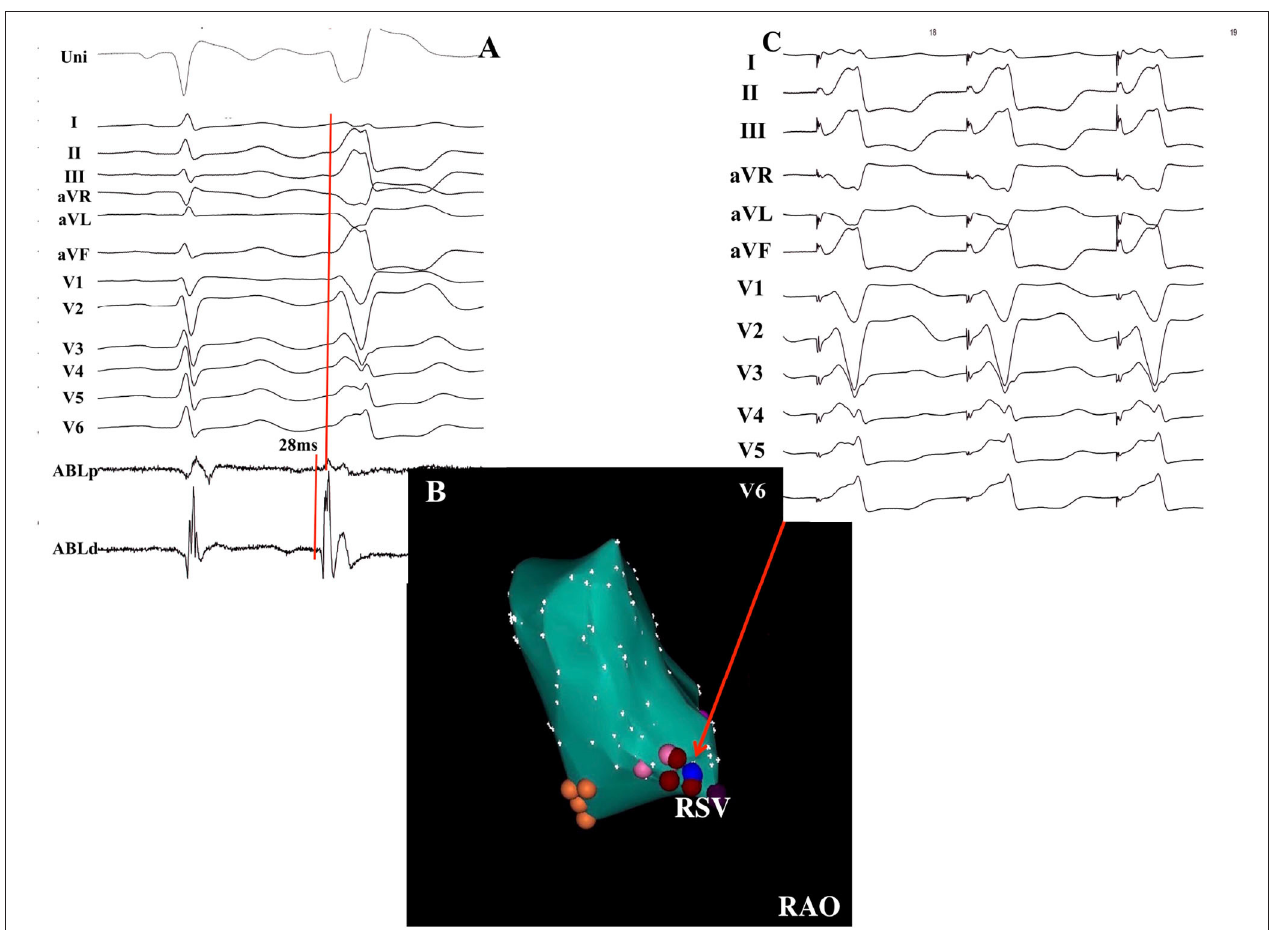
FIGURE 4 | Successful ablation of PVCs without DPPs in a 63-year-old female patient. (A) The earliest activation recorded at the RSV preceded the QRS complex onset by 28ms without DPPs. (B) Electroanatomical CARTO map of the PVCs in the RAO view. Red points indicate the ablation points. Blue point indicates the pacing site. Orange points indicate the non-coronary sinus of Valsalva. (C) Pacing mapping was excellent when pacing was delivered at the ablation site. RSV, right sinus of Valsalva; DPP, discrete pre-potential; RAO, right anterior oblique.